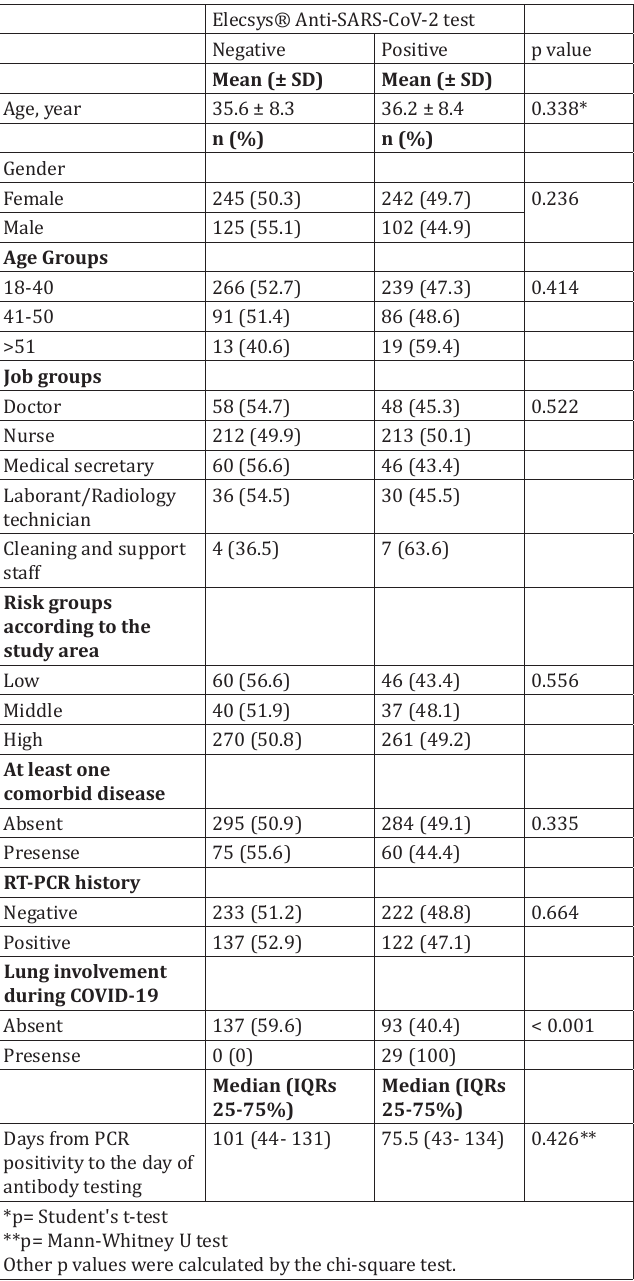
Comparison of clinical characteristics and antibody levels of HCWs